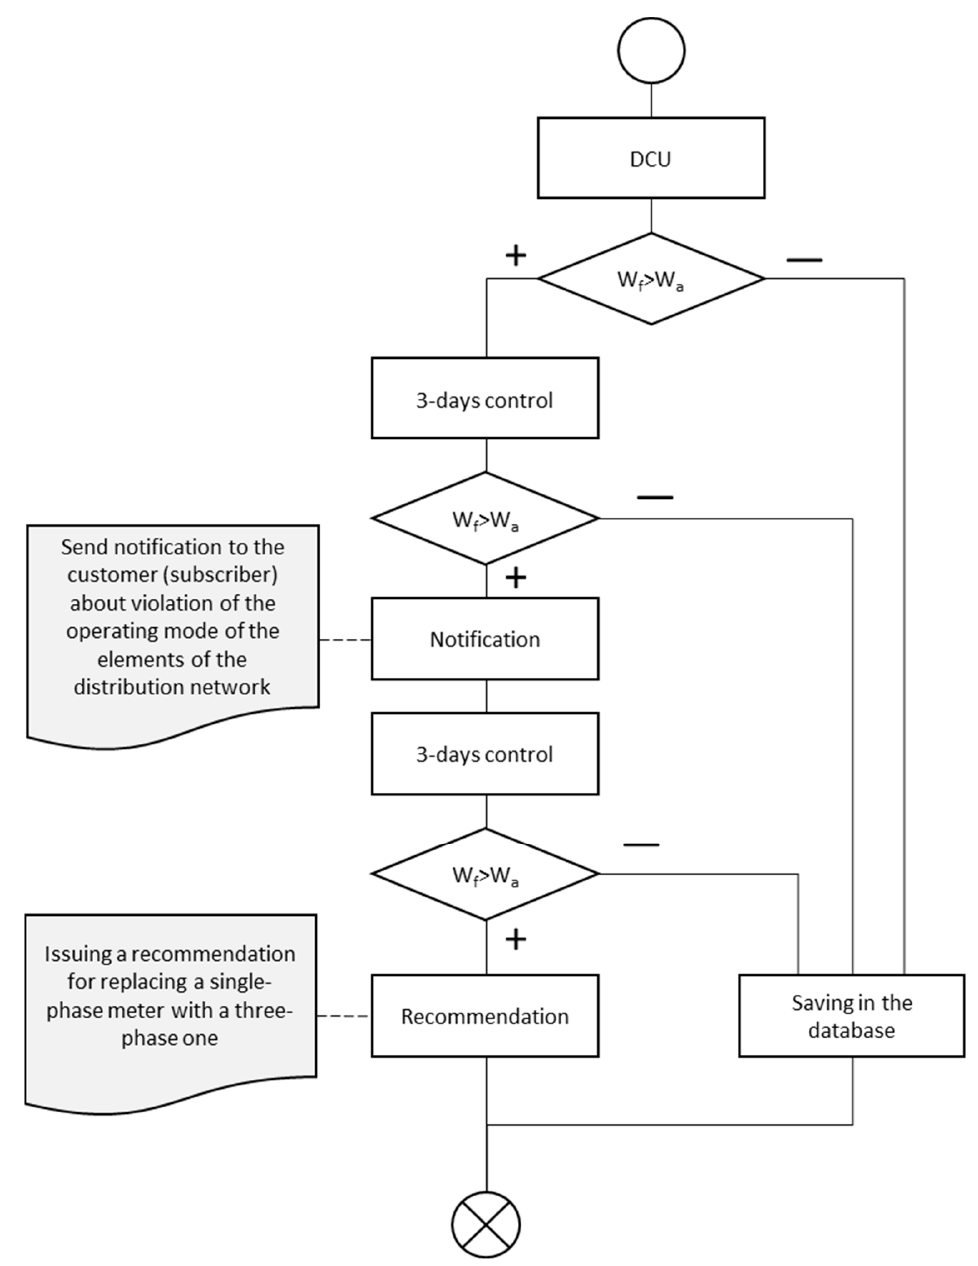
Figure 2. Algorithm for monitoring energy consumption using smart electricity meters.